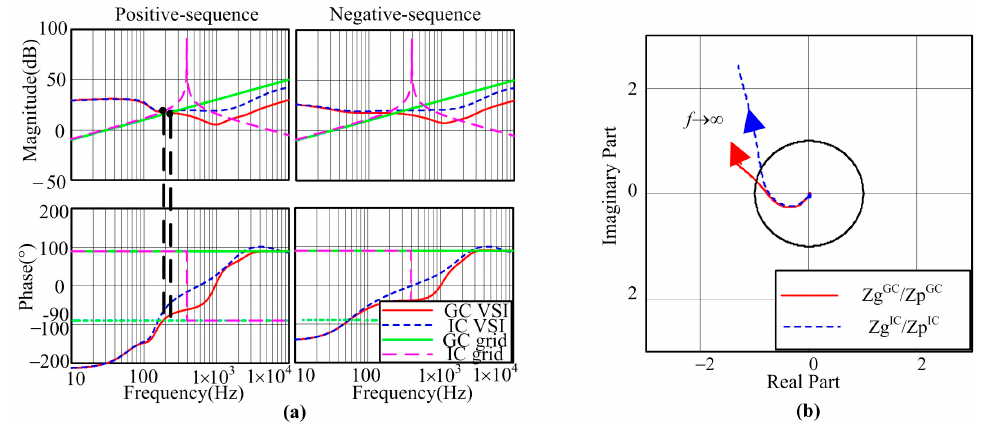
Figure 15. Impedance-based stability analysis results under different sampling currents when L g = 5 mH. ( a ) Impedances of VSI and the grid; ( b ) Nyquist plot of impedance ratio.